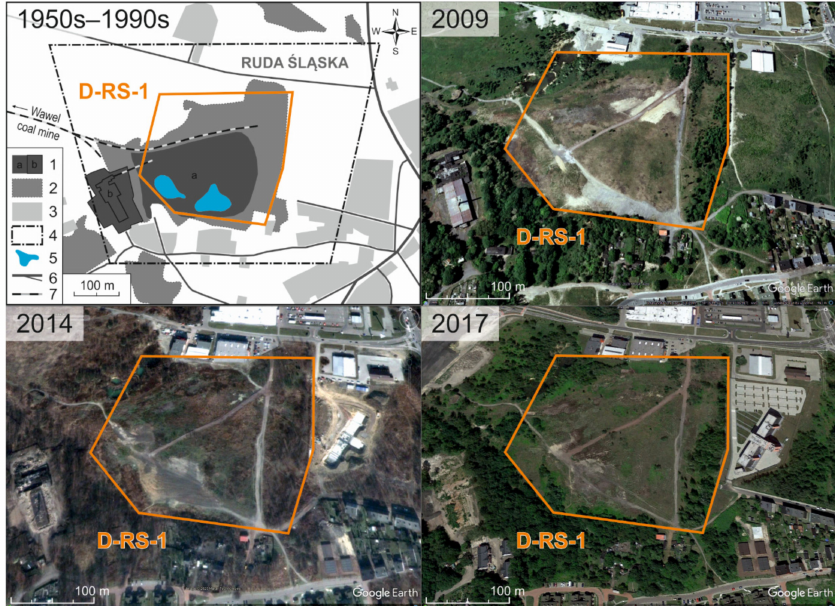
Figure 2. Historical cartographic data for the dump D-RS-1: 1a: clay pit in the 1990s, 1b: brickyard in the 1950s–1990s, 2: clay pit in the 1950s–1980s, 3: other buildings in the 1990s, 4: orthophotomaps range, 5: surface water in the 1990s, 6: roads in the 1990s, and 7: railways in the 1900s.